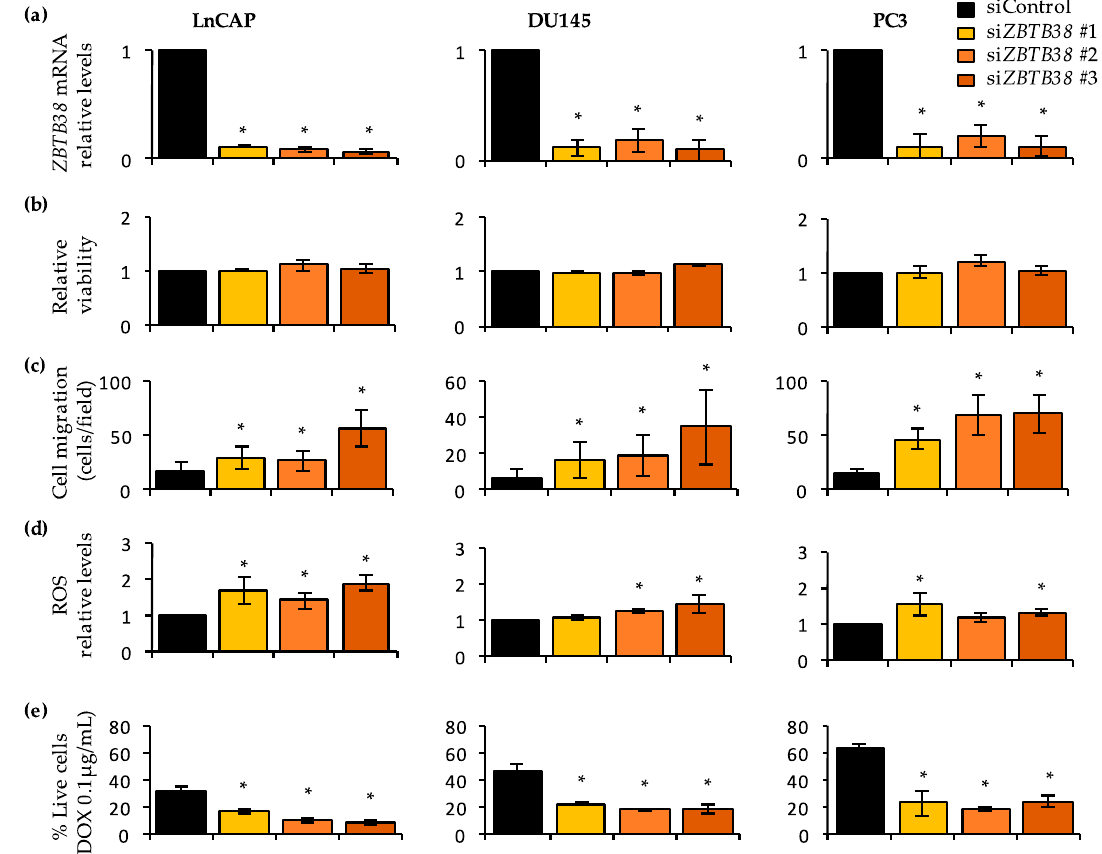
Figure 5. Knock-down of ZBTB38 promotes ROS accumulation, cell migration and doxorubicin sensitivity in prostate cancer cell lines. ( a ) RT-qPCR validation of ZBTB38 depletion 48 hours after transfection of control and ZBTB38 siRNAs in prostate cancer cell lines LnCAP, DU145 and PC3 ( n = 3). ( b ) Consequence of ZBTB38 depletion on cell viability monitored by propidium iodide intake, 48 hours after transfection of control and ZBTB38 siRNAs ( n = 3). ( c ) Consequence of ZBTB38 depletion